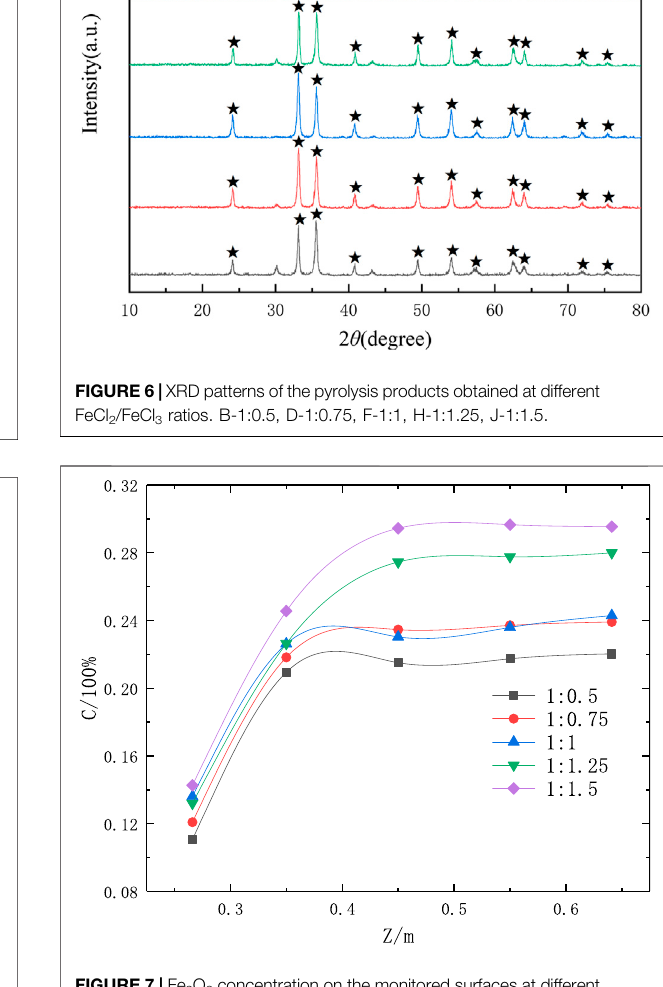
FIGURE 5 | The average Fe 2 O 3 concentration on monitored surfaces at different temperatures.